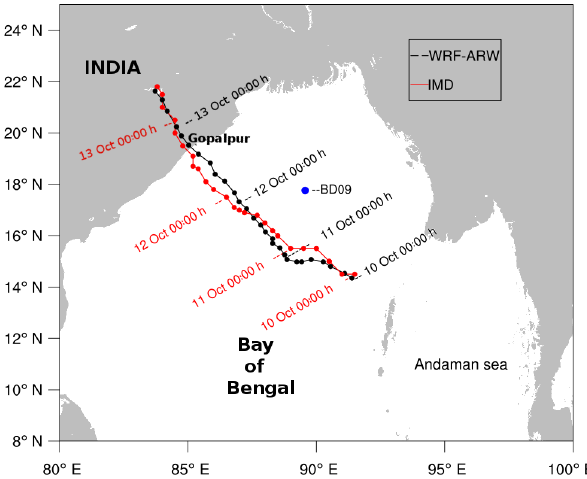
Figure 3. Tracks of Phailin simulated by the coupled model (black) and IMD reported (red). The 3-hourly positions of the center of Phailin are marked with solid circles, and the daily position at 00:00h is labeled with the dates. Location of buoy BD09 is marked with a blue circle. Figure 4. Comparison of coupled model (green), stand-alone WRF